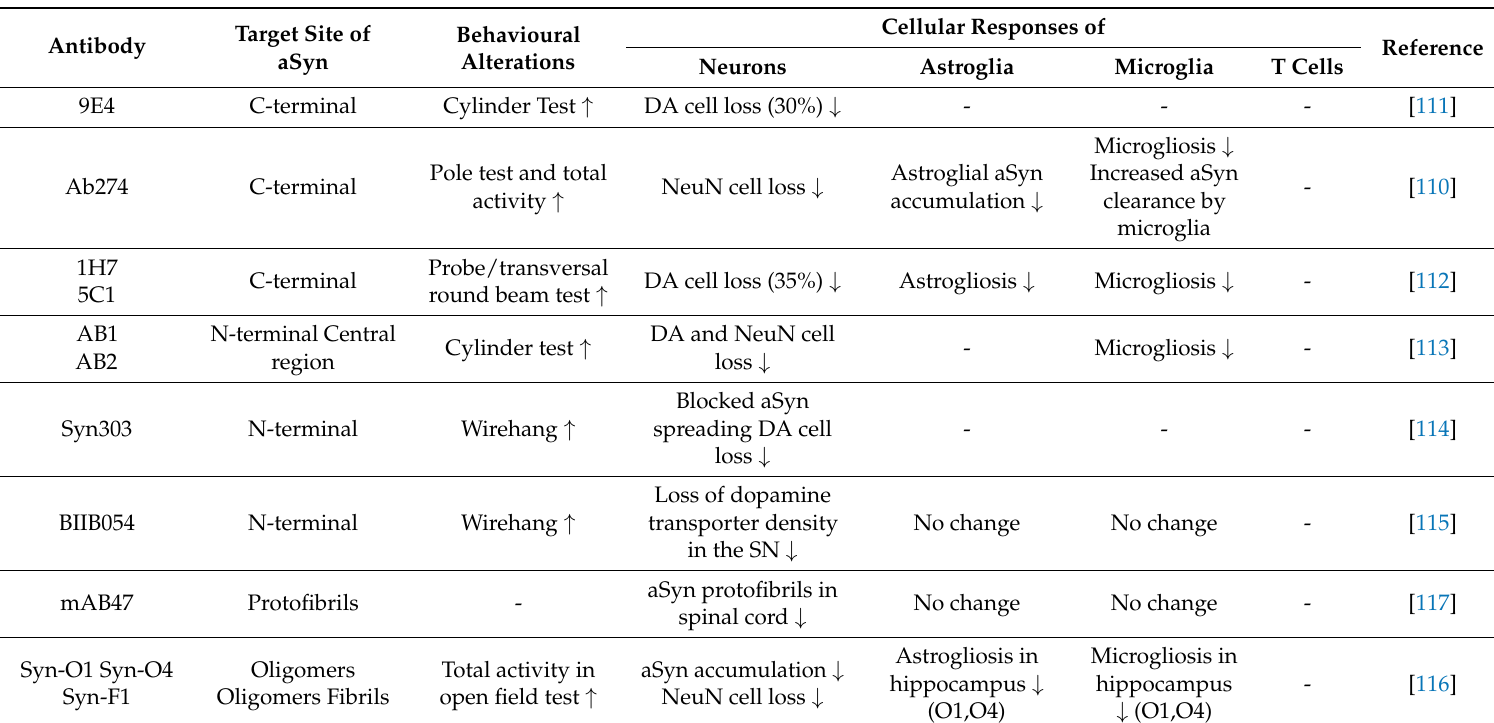
Table 1. Passive immunization studies in Parkinson’s disease animal models and therapeutic